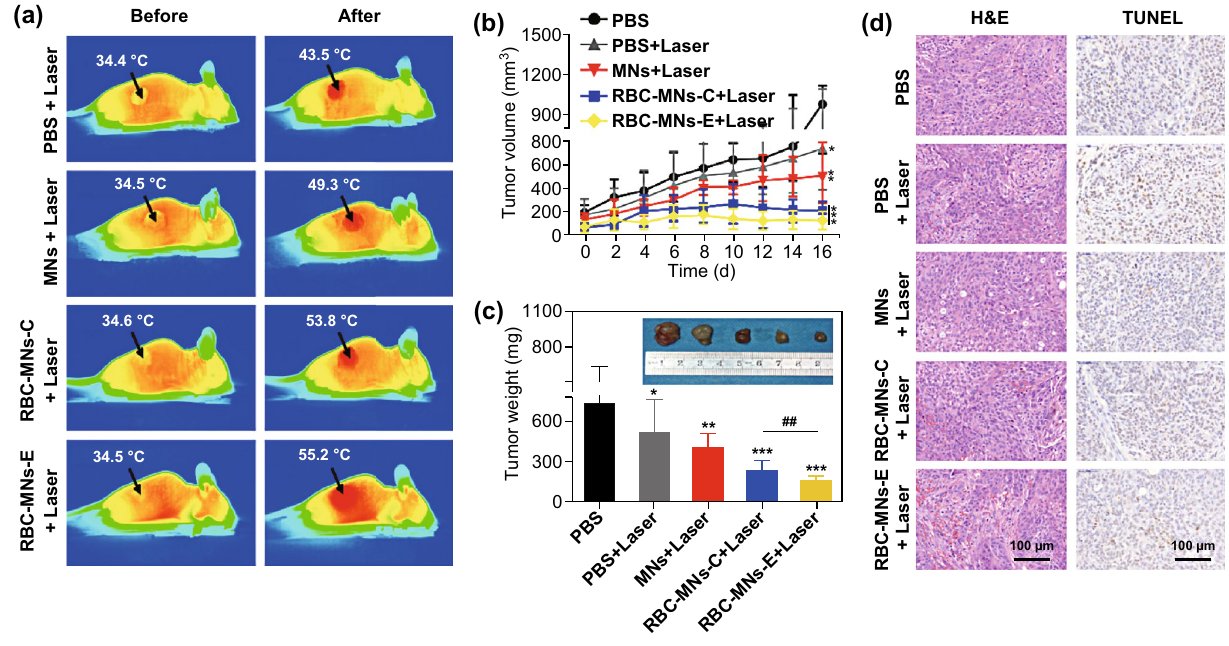
Fig. 5 a Infrared imaged from representative mice before and after treatments, with black arrows indicating tumor sites. b Tumor volumes over time in treated animals. c Tumor weights in differentially treated animals, with inset images displaying representative ex vivo tumor images at the end of treatment. d Representative H&E‑ and TUNEL‑stained images from differentially treated mice. Data are mean ± SEM ( n = 6). * p < 0.05, ** p < 0.01, and *** p < 0.001 relative to control, respectively, and## represents p < 0.01 relative to conventional extrusion method. Adapted from Ref. [97] with